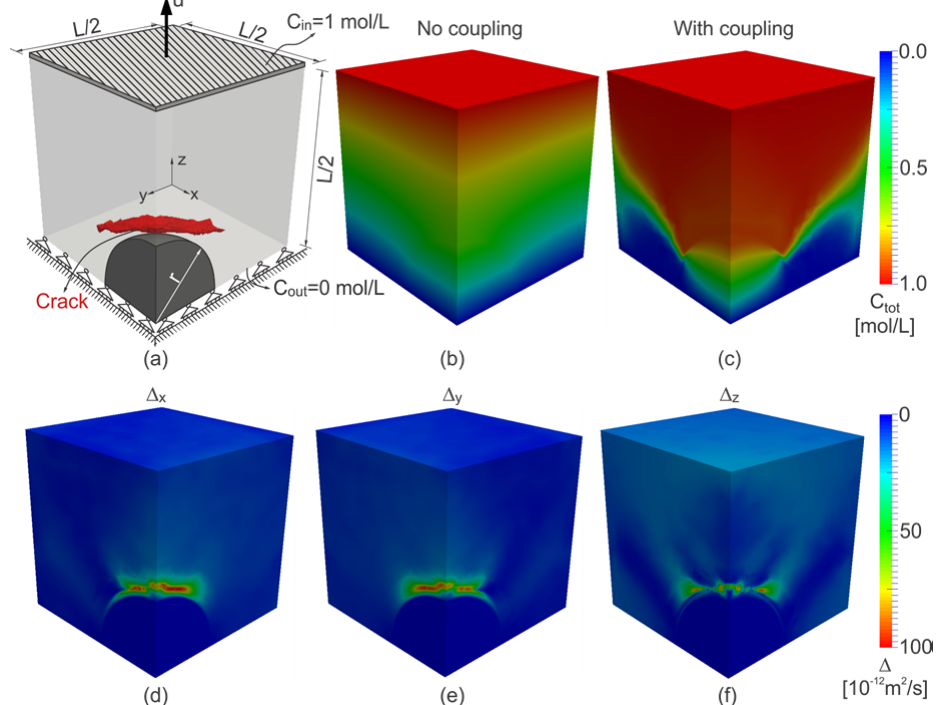
Figure 4. Results of simplified mesoscale simulations (no ITZ, spherical aggregate): (a) crack pattern and mechanical/diffusive boundary conditions, chlorides concentration profile (b) neglecting and (c) accounting for the coupling between phase ‐ field and diffusivity, cracked material diffusivity in (d) x , (e) y and (f) z